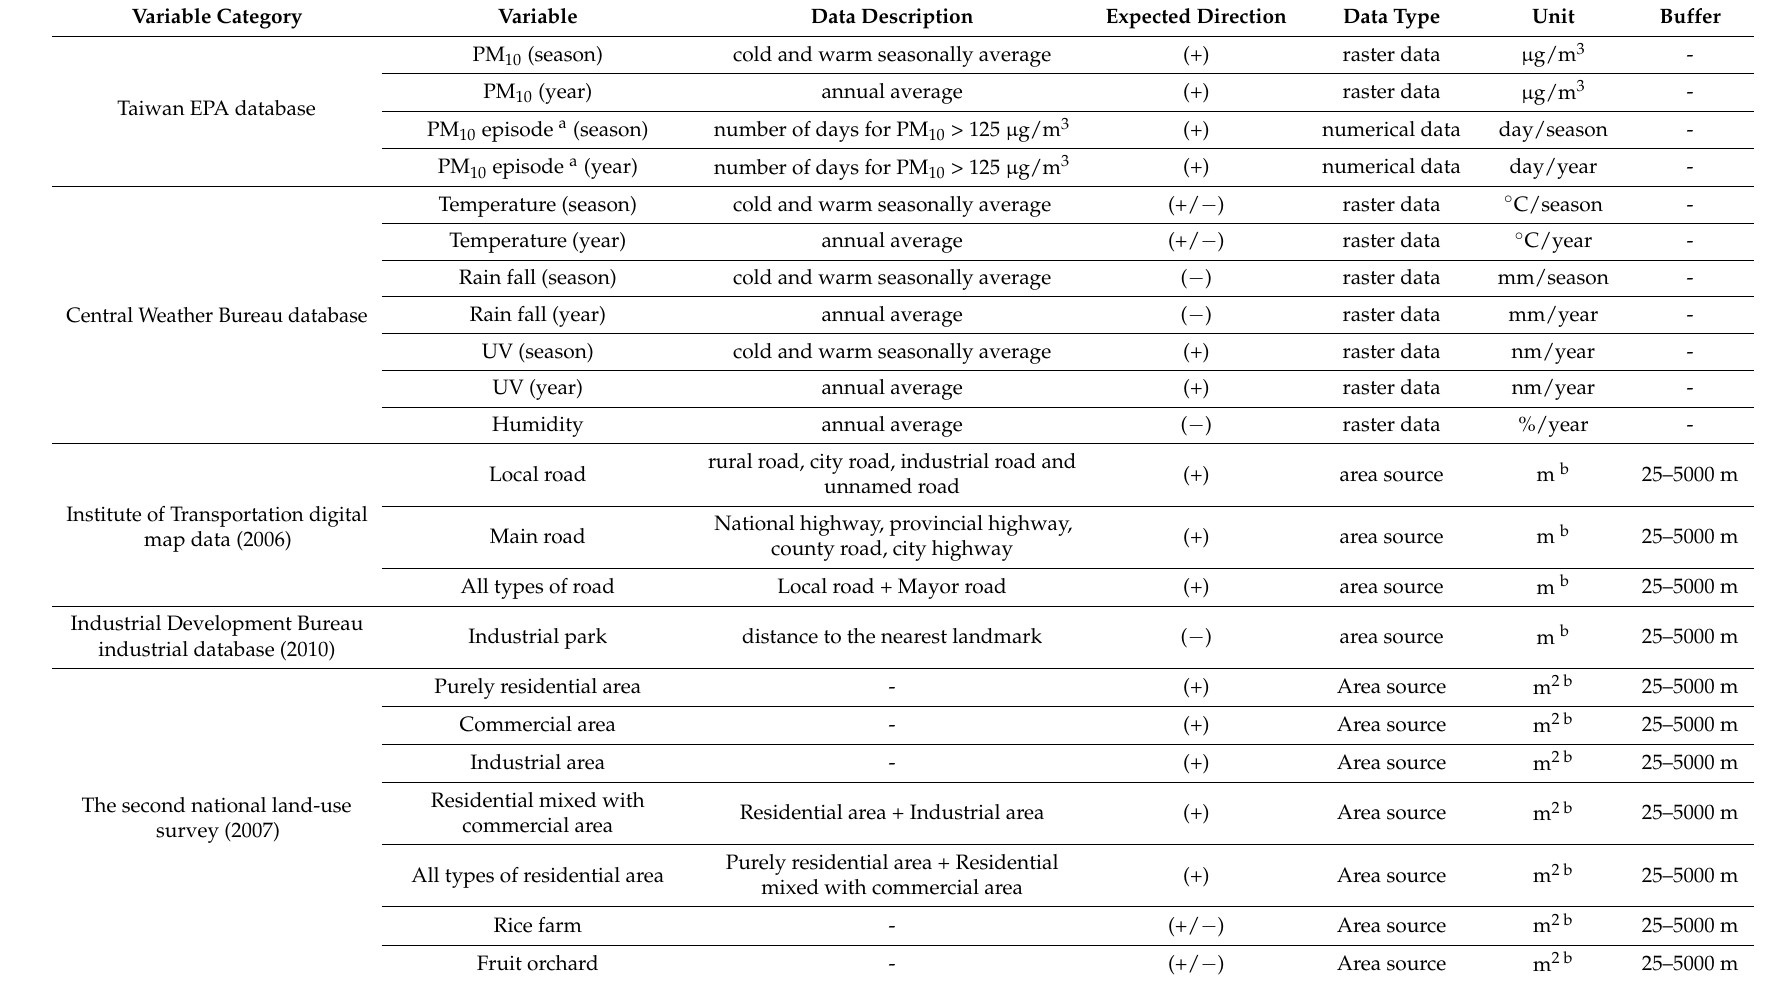
Table 1. List of potential predictor